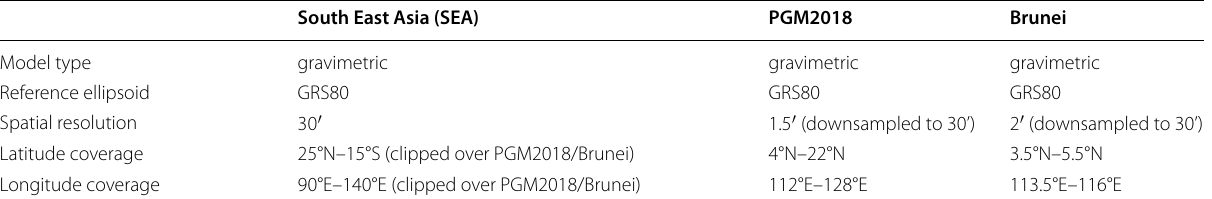
Table 4 Characteristics of the SEA, PGM2018, and Brunei geoid models, used as input for the local and regional geoid comparison example